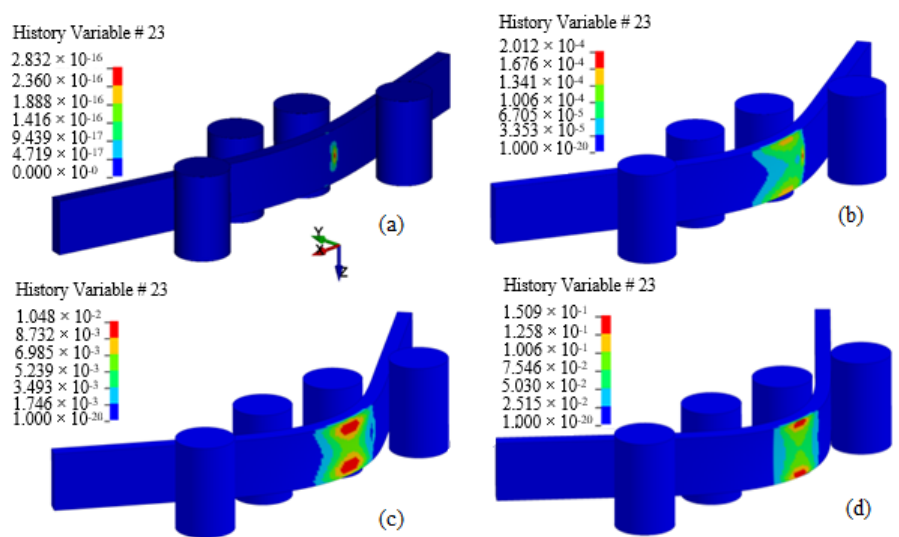
Figure 16. Evolution of damage with the addition of GISSMO damage formulation to SAMP-1 material law at different indenter displacements: ( a ) 5 mm, ( b ) 8.8 mm, ( c ) 11.2 mm, and ( d ) 14 mm.